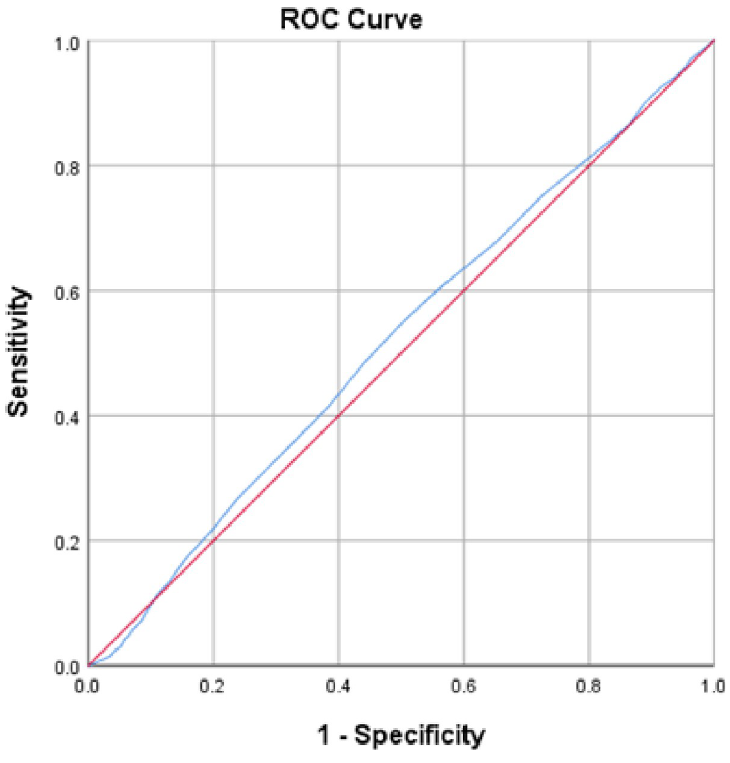
Fig 3. ROC curve of FCV-19S for